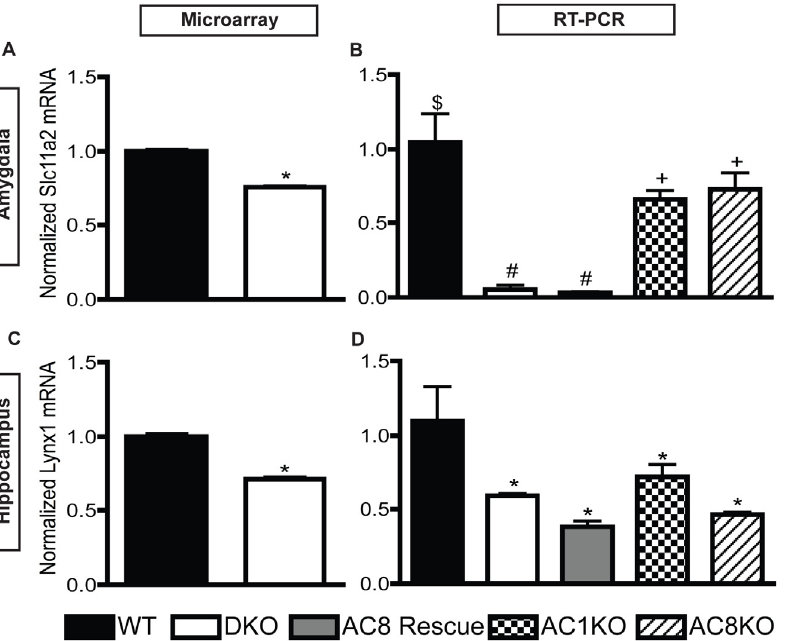
Figure 1. Developmental changes in DKO mice. Two genes identified with microarray analysis and showing the most significant change between WT and DKO mice, ( A ) Slc11a2 (n=5, *p # 0.0001), with a 2 1.3 fold change, and ( B ) Lynx1 (n=5, *p # 0.0001), with 2 1.4 fold change, were confirmed via RT-PCR. ( C – D ) Both RT-PCR results confirmed a significant decrease in Slc11a2 (n=4–5, $ vs # p # 0.001; $ vs + p # 0.05; # vs + , p # 0.001) and Lynx1 (n=4–5,*p # 0.05). RT-PCR results also reveal that these gene changes are not rescued in AC8 rescue mice, and therefore, do not modulate the CF learning changes, but rather, probably contribute to baseline changes. No differences in gene expression between AC1KO and AC8KO mice suggest that these genes are not targeted by one specific Ca2 + -stimulated